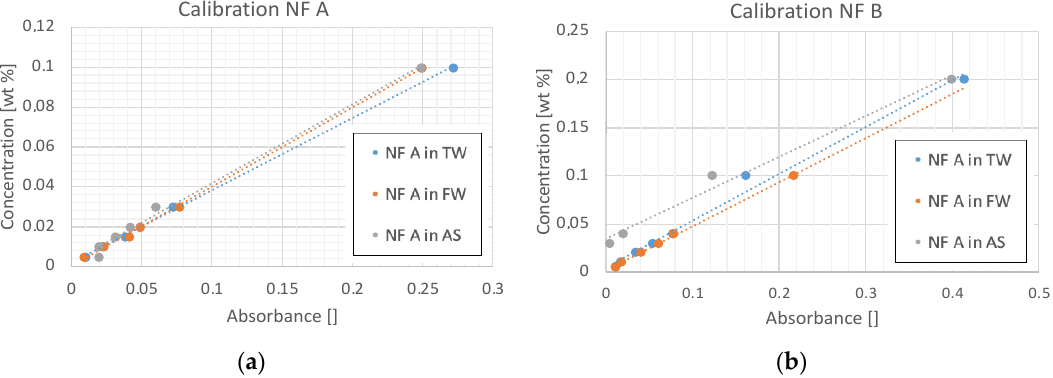
Figure 5. Calibration graph for different concentrations of NF A ( a ) and NF B ( b ) in TW, FW and AS. Solutions were left resting for 24 h after mixing and filtered using a 0.45 µm filter. A linear trend was found to fit the measured behaviour best for all solutions. These calibration plots enable the calculation of nanoparticle concentration from an absorbance measurement. Table 4. Calibration constants for 24 h aged nanofluid solutions after filtration at 270 nm and Absorbance correction factors for rock materials. These constants were later used to calculate nanoparticle concentrations from UV–Vis absorption measurements (FW: formation water, TW: test water, AS: alkali solution). Absorbance in different brines at two temperatures using doublet measurements and an average standard deviation for absorbance at 270 nm of 3.8 × 10 − 3